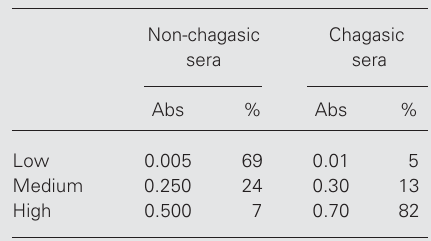
Table 1. Reactivity with Trypanosoma cruzi total extract of sera from patients with non-chagasic and chagasic heart disease.